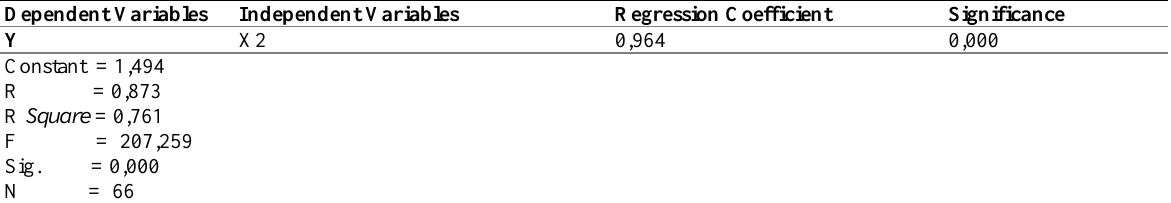
Table 3: Simple Regression